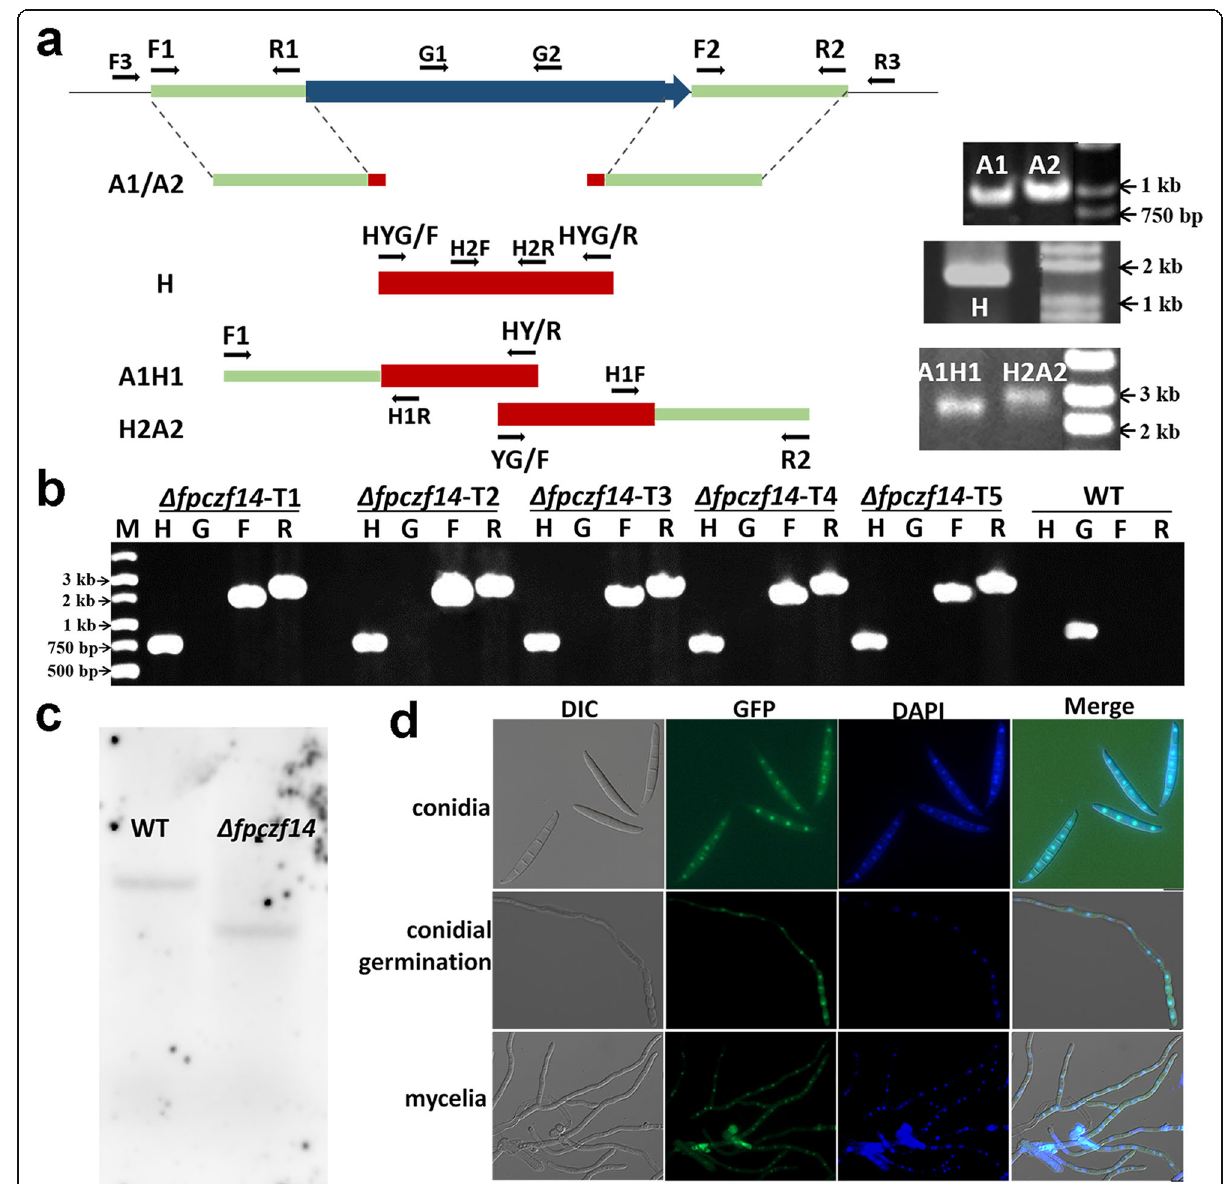
Fig. 2 Construction of FpCzf14 -deleted mutant and complementation strain, and subcellular localization of FpCzf14. a Schematic representation of the FpCzf14 deletion strategy and PCR amplification. b PCR products for the FpCzf14 gene replacement construct. M, DNA size marker; H, a 750-bp fragment of the hygromycin phosphotransferase gene ( hph ); G, a 806-bp fragment of the FpCzf14 gene; F, a 1479-bp fragment of FpCZF14 and hph upstream cassette; R, a 1691-bp fragment of FpCZF14 and hph downstream cassette. c Southern blot analysis of WT and Δ fpczf14 -T1 with a 1027-bp fusion fragment containing 562- bp FpCzf14 upstream sequence and 465-bp hph as a probe. The genomic DNA of each strain was digested with Xba I. d The expression and localization of FpCzf14-GFP in Δ fpczf14 mutant using its native promoter. The nuclei were stained with DAPI (4 ′ ,6-diamidino-2-phenylindole) and examined by